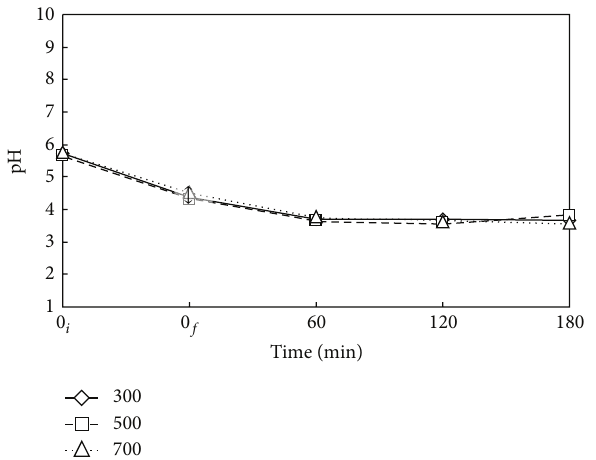
Figure 3: Time variation of pH value for the decomposition of DMP via WOP at various Nr. ⬦ , ◻ , and △ : Nr = 300, 500, and 700 rpm. 𝐶 0 = 100mg L −1 , 𝑉 𝐿 = 400mL, 𝑇 = 473 K, and 𝑃 𝑇 = 2.41 MPa. Working gas after time = 0 𝑓 is O 2 . ↕ : Mean and Standard deviation (SD, 𝑛 − 1 method) at 𝑡 = 0 𝑓 : 4.4 ± 0.1.